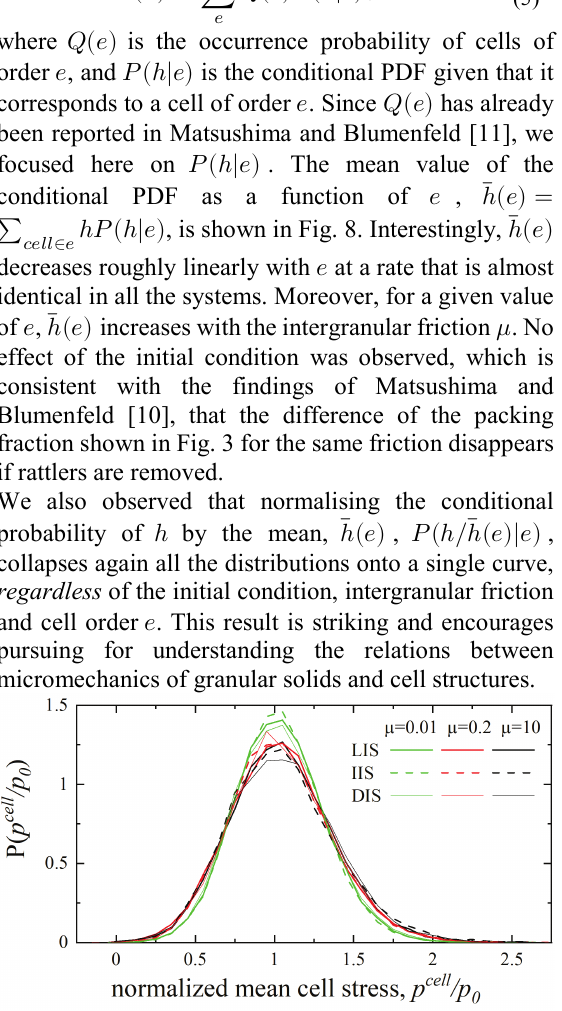
Fig. 4. PDFs of the mean cell stress normalised by the bulk external pressure 𝒑𝒑 𝟎𝟎